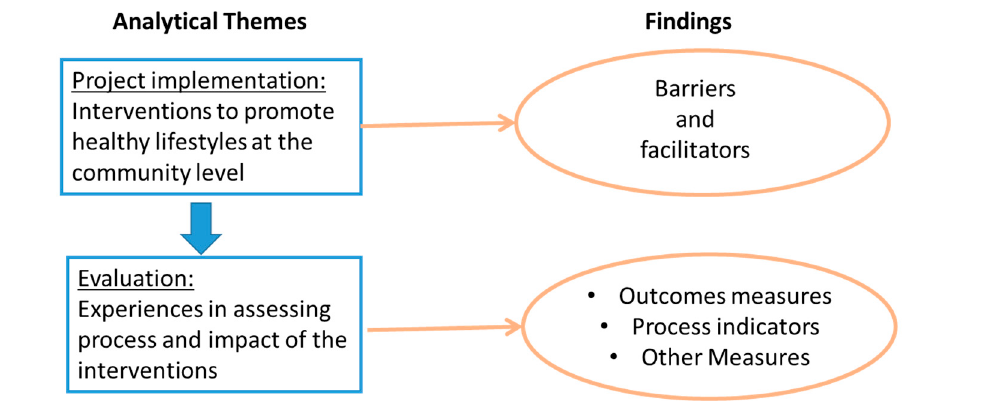
Figure 1. Theoretical framework.